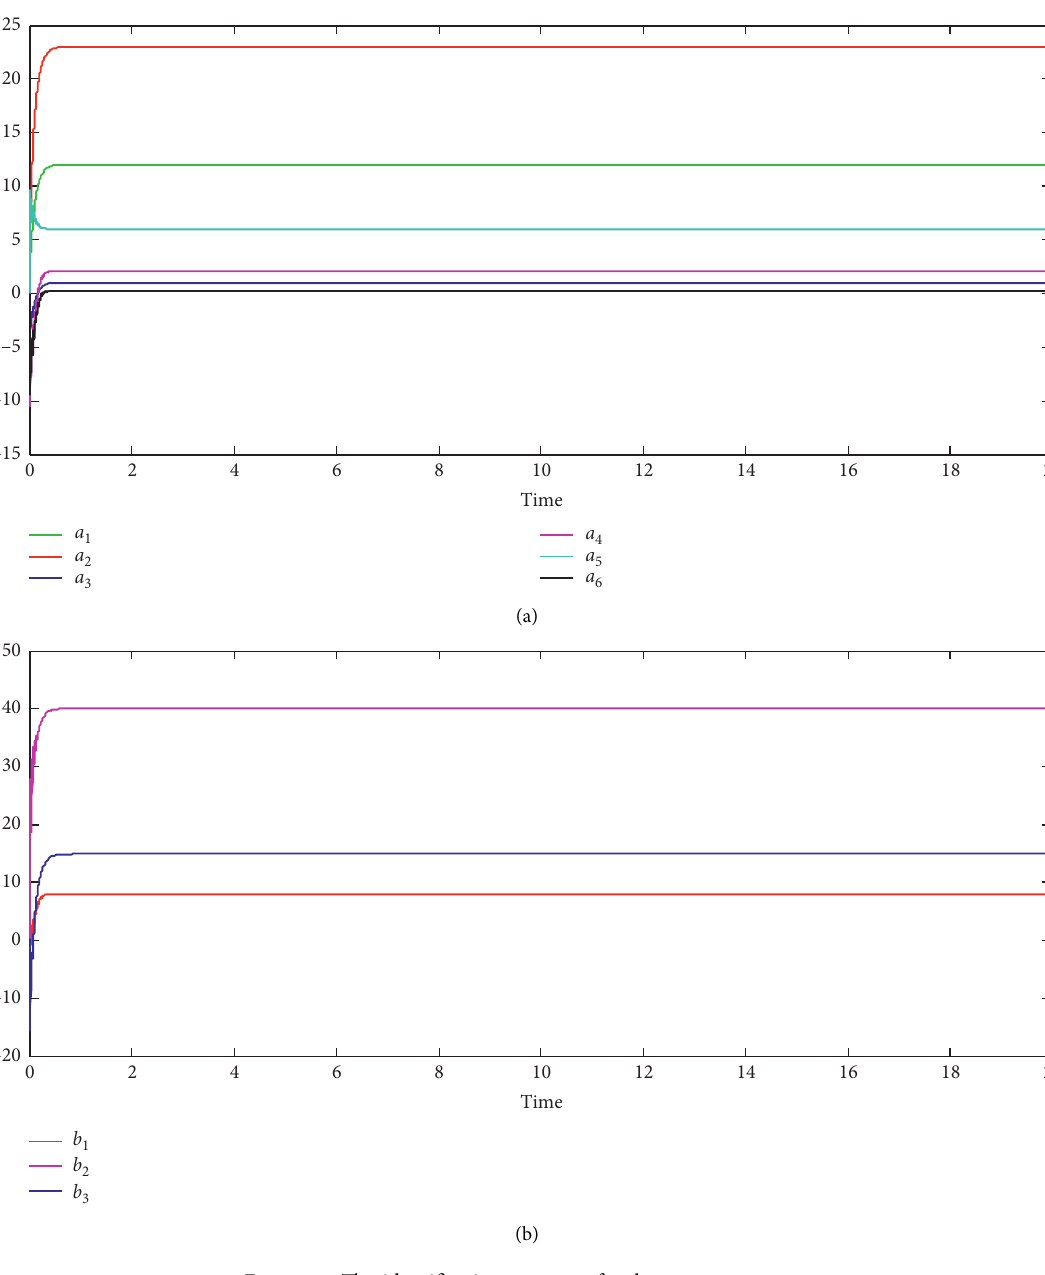
Figure 7: The identification process of unknown parameters.